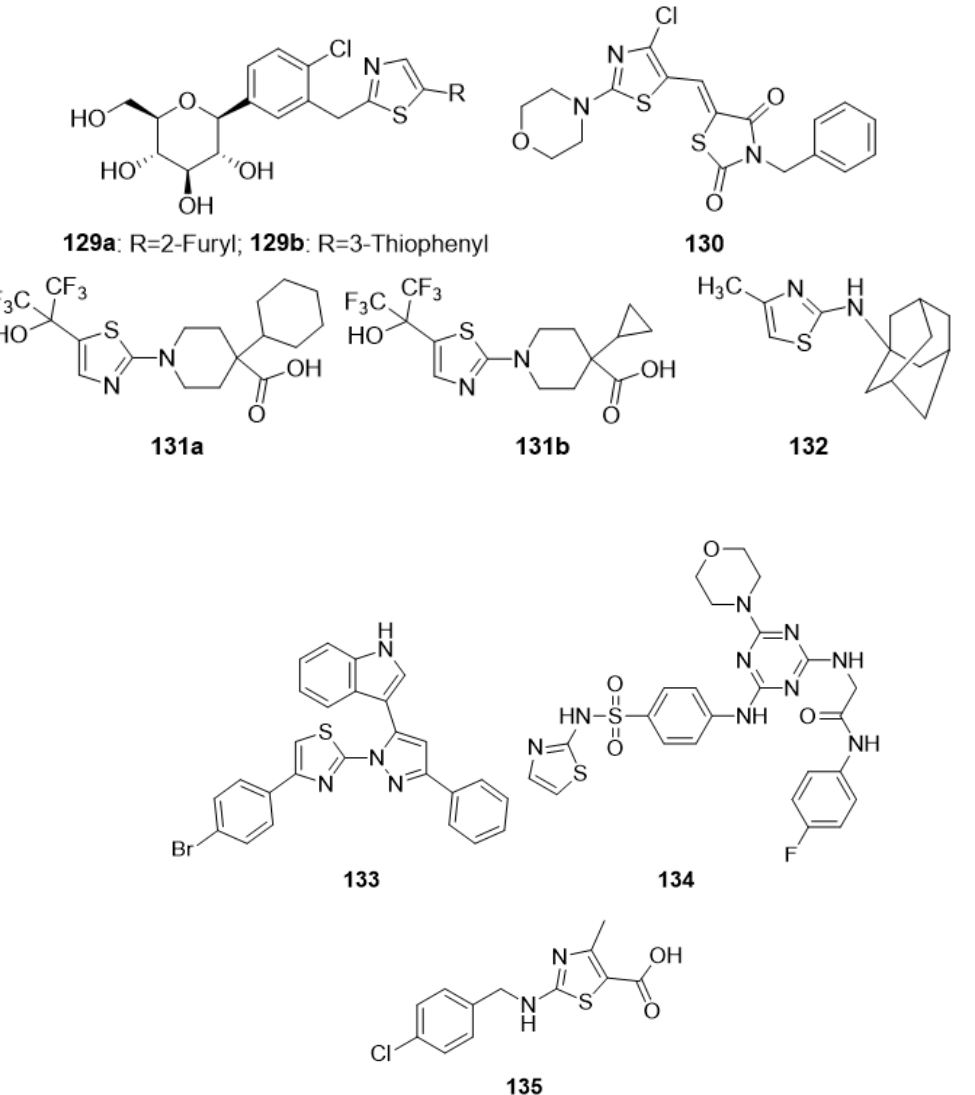
Figure 11. Recently designed and synthesized thiazoles as potential anti-diabetic